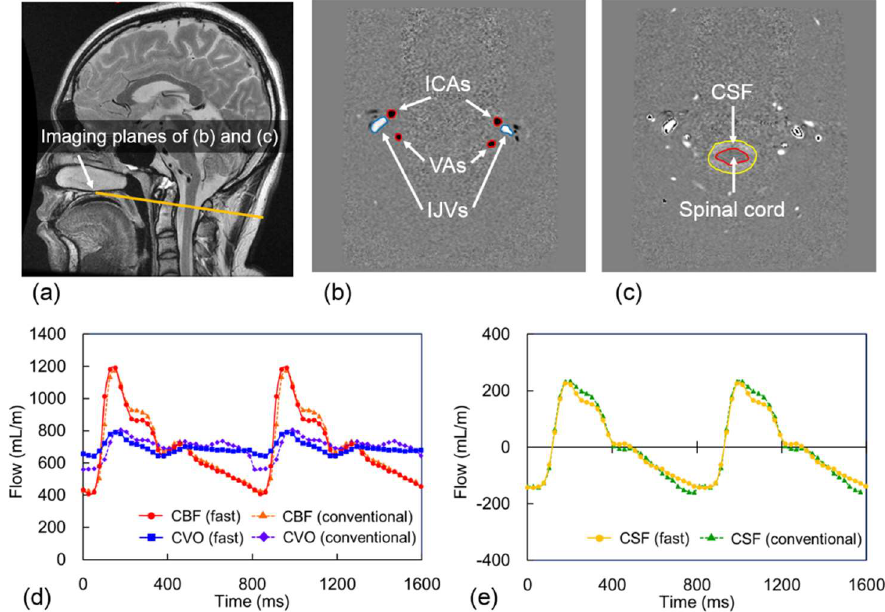
Figure 2. Examples of midsagittal T 2 -weighted and velocity-mapped PC images. ( a ) Imaging plane (yellow line) for ECG-synchronized PC-cine MRI. ( b ) Velocity-mapped PC-cine MRI of arterial inflow (right and left internal carotid arteries (ICAs) and vertebral arteries (VAs)) and venous outflow (both internal jugular veins (IJVs)). ( c ) Velocity-mapped PC-cine MRI of the cerebrospinal fluid (CSF) flow and spinal-cord displacement. Examples of volumetric flow waveform of ( d ) cerebral blood flow (CBF, sum of both side ICAs and VAs) and cerebral venous outflow (CVO, sum of both side IJVs and secondary cervical veins), and ( e ) CSF flow with proposed fast and conventional PC-cine MRI.